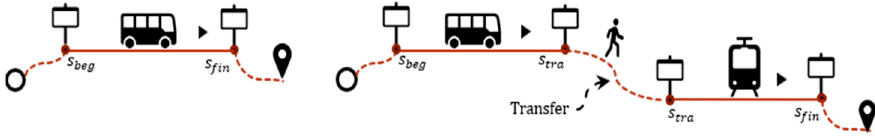
Figure 4. In the left, an example of single-stage trip having a beginning s beg and final s fin stop. In the right, an example of multi-stage trip having transfer stops s tra also.